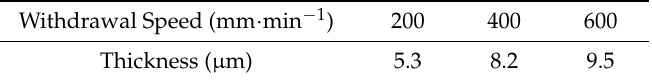
Table 3. Coating thickness for each withdrawal speed-bilayer systems.